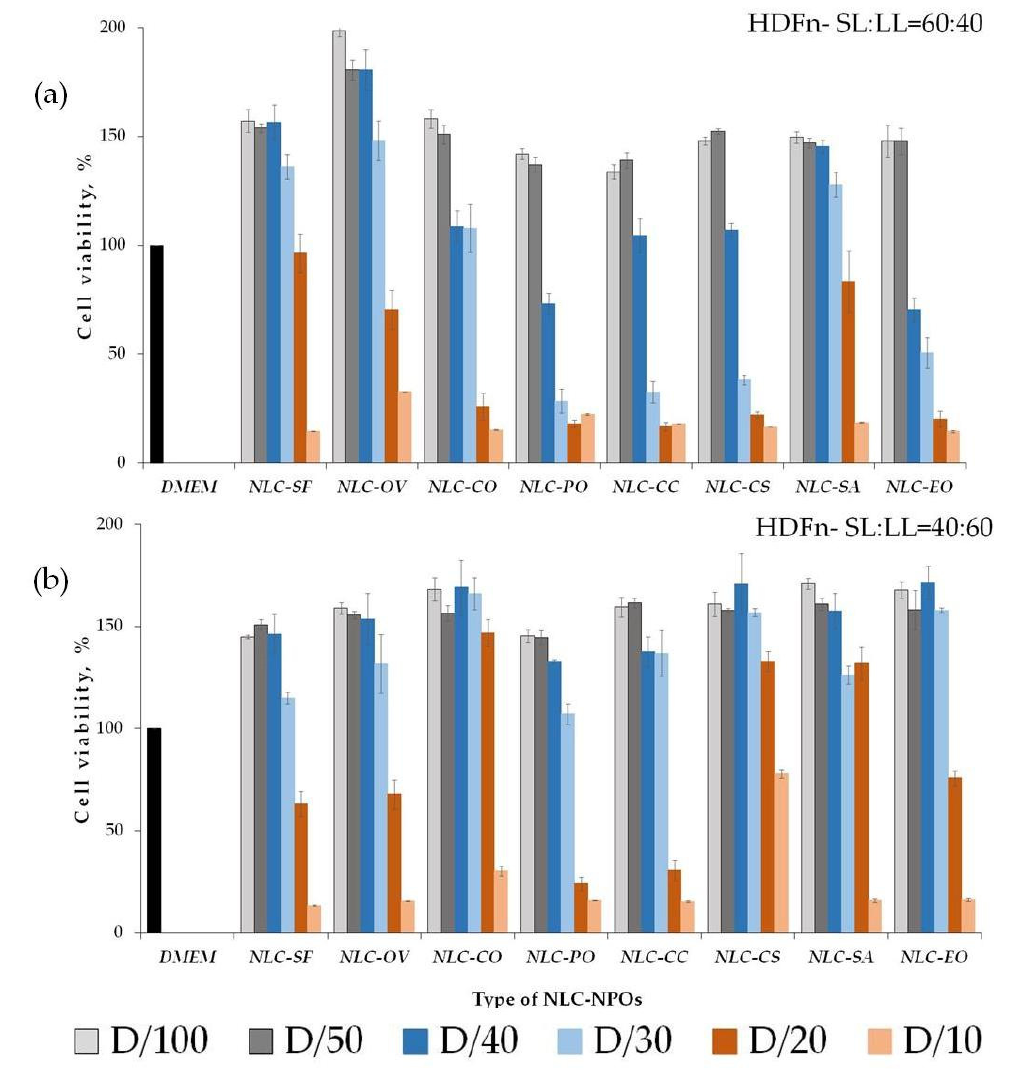
Figure 6. Cytocompatibility (viability %) of fibroblasts (HDFn): ( a ) 60:40; ( b ) 40:60 with all the nanoparticle suspensions; dilution (D) 1/10, 1/20, 1/30, 1/40, 1/50, and 1/100. Notes: Medium (DMEM) was used as comparison (positive control) (mean value ± SD; n = 3).